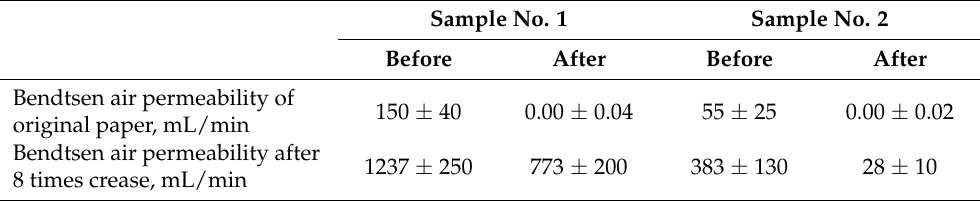
Table 3. Air permeability of paper sample nos. 1 and 2 before and after modification and crease. Sample No.